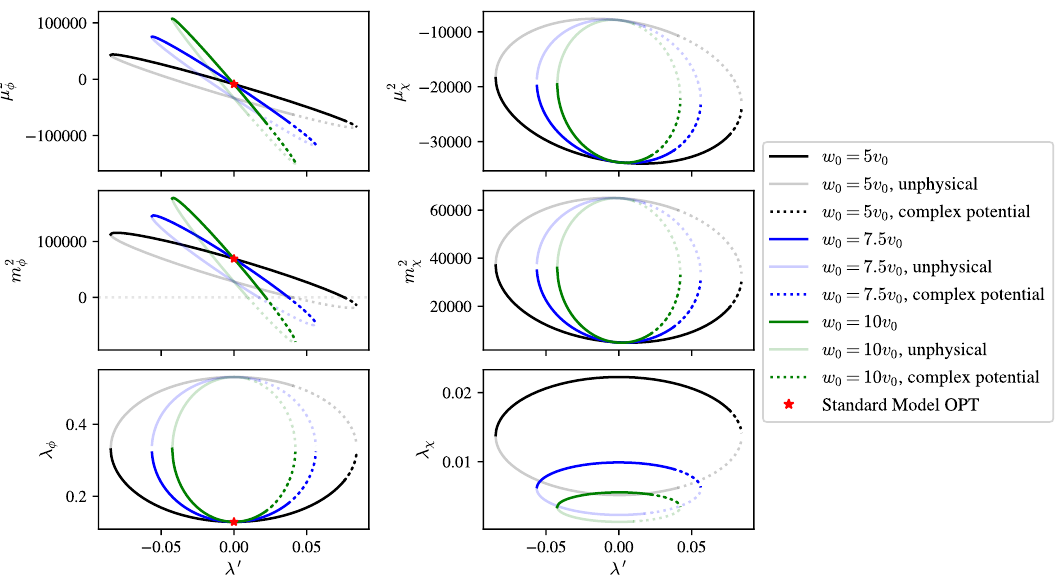
Figure 3 . Parametrization of the singlet extended SM for M s = 260 GeV at various values of VEV w 0 . The solid curves indicate physical solutions where the potential remains real for all values of the background fields. The light solid curves are the unphysical solutions, while the dotted lines indicate parameter values where the potential becomes complex in some region of v < v 0 and w < w 0 .